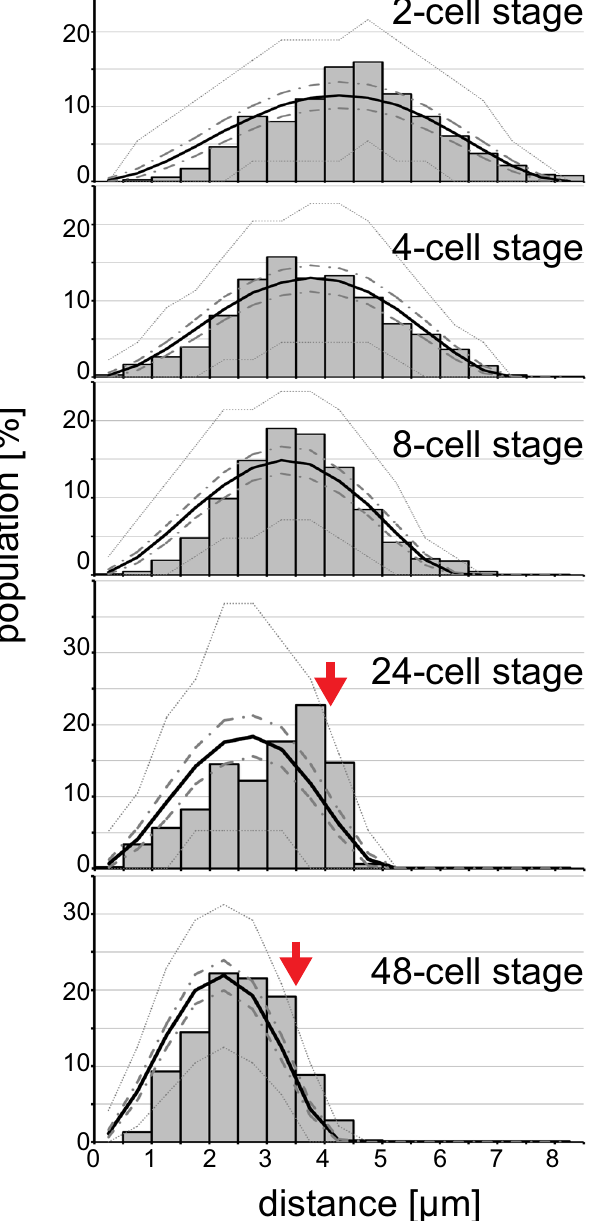
Figure 2. Distribution of distances between lacO loci. Histograms of the distances between the two lacO spots in each developmental stage. Sample sizes are indicated in Supplementary Table S3 (“the number of pairs of lacO spots”). Black solid lines indicate the expected distribution of the distances if the two spots were randomly positioned in a nucleus of the same size, predicted from a Monte Carlo simulation. The average sizes of the nuclei at each stage are described under “radius” in Supplementary Table S3. Thick dotted lines indicate the upper and lower limits of the 95% confidence interval calculated from a random simulation with the number of pairs equal to that of the lacO spots for each stage as described under “the number of pairs of the lacO spots” in Supplementary Table S3 (see Methods). Similarly, thin dotted lines indicate the limits when the number of random pairs was the same as the number of nuclei examined as described under “the number of nuclei” in Supplementary Table S3. The latter corresponds to an extreme situation where the two spots do not move at all in each nucleus, and thus the expected variation in the distribution is large. Red arrows indicate where the experimentally obtained distribution did not agree with the random position scenario. Differences in the distributions among different stages are more directly compared in Fig. S3, where the distances between the lacO spots were normalised by the radius of the